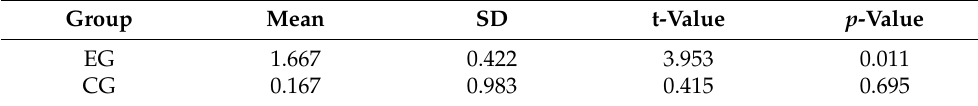
Table 1. Statistics of verbal responses of condition NM1 (S1) and NM1 (post S4).